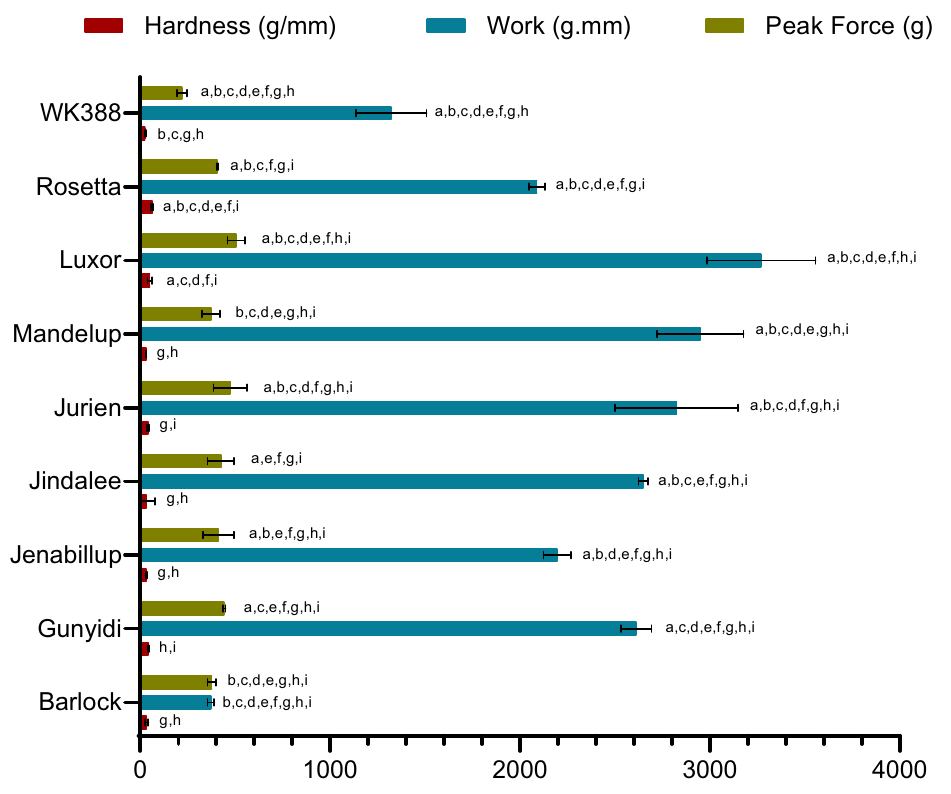
Figure 2. Texture analysis parameters of lupin flours of different cultivars. Data are means of three replicates with standard deviations (SD). Pair-wise comparison by Post Hoc Tukey test, bars with alphabetic characters demonstrate significant differences ( a P < 0.05 vs. Barlock; b P < 0.05 vs. Gunyidi; c P < 0.05 vs Jenabillup; d P < 0.05 vs. Jindalee; e P < 0.05 vs Jurien; f P < 0.05 vs. Mandelup; g P < 0.05 vs Luxor; h P < 0.05 vs Rosetta; i P < 0.05 vs